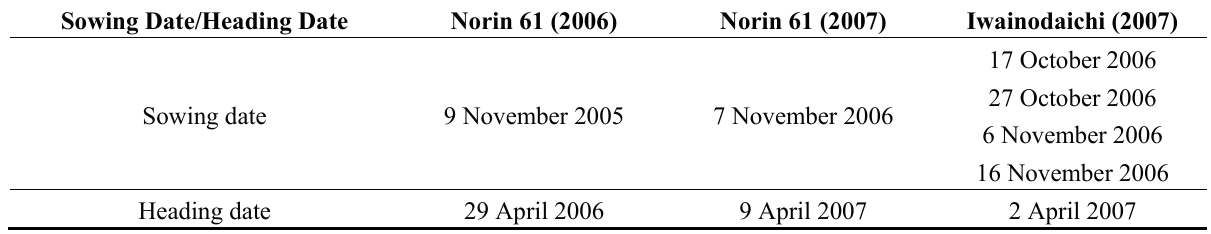
Table 1. Sowing and heading dates of winter wheat in the experimental field.